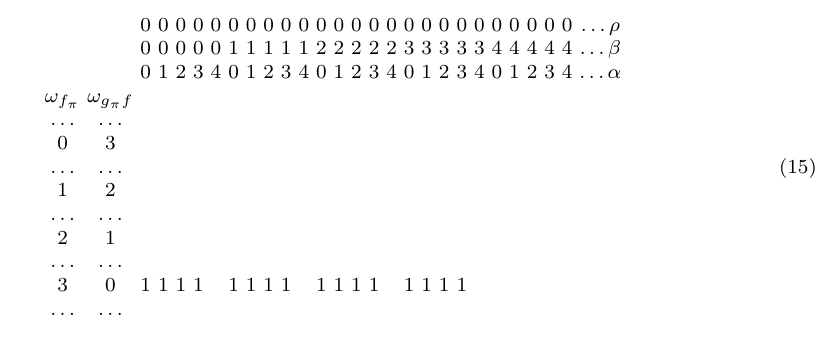
Figure 15: Vulnerability profile of CMS scheme with s = 4 when using additional randoms q j .